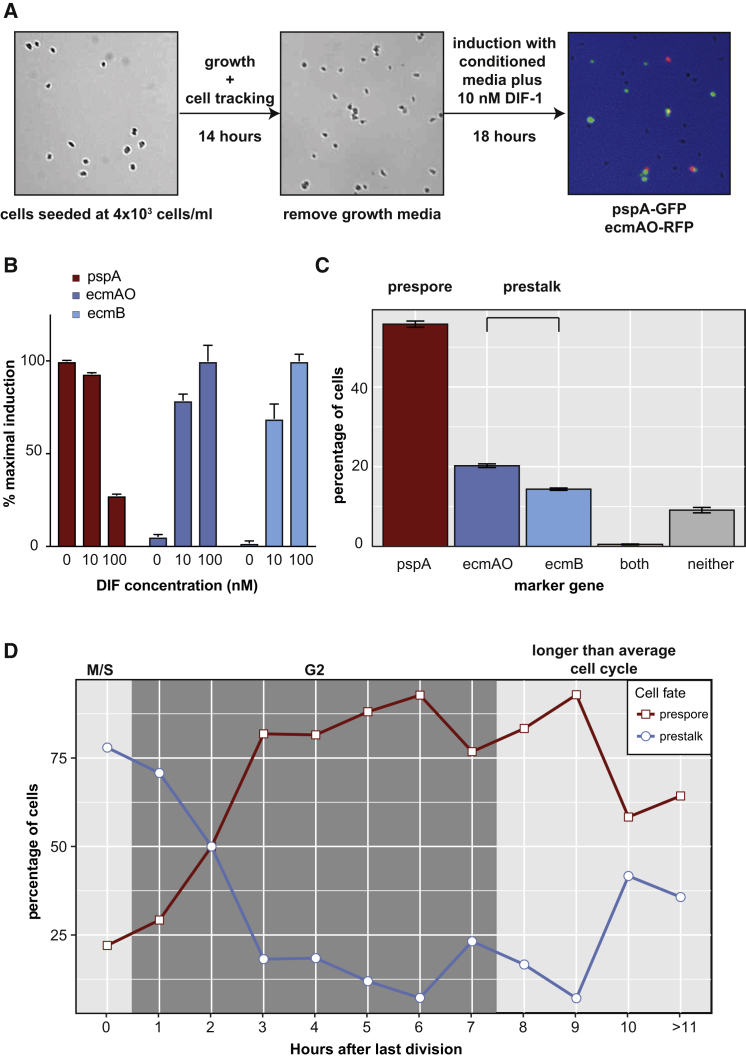
A Probabilistic Relationship between Cell Fate and Cell Cycle Position(A) Schematic of high-throughput, low-density growth and differentiation assay.(B) Dose-responsive induction and repression of prestalk and prespore marker gene expression. AX3 cells transformed with pspA-RFP, ecmAO-RFP, or ecmB-RFP cell type-specific reporters were incubated with indicated DIF-1 concentrations, and number of expressing cells determined by FACS.(C) Cell type differentiation at 10-nM DIF-1. AX3 cells co-transformed with pspA, ecmAO, or ecmB cell type specific reporters were incubated with 10-nM DIF-1 and the number of expressing cells determined by FACS (see STAR Methods).(D) Cell type differentiation is cell-cycle-dependent. 448 cells were tracked during growth and differentiation. Percentages of cells that differentiated as prespore or prestalk cells (ecmAO or ecmB expressing) were calculated for cells dividing within each hourly time interval before induction. The likely cell cycle position is highlighted.